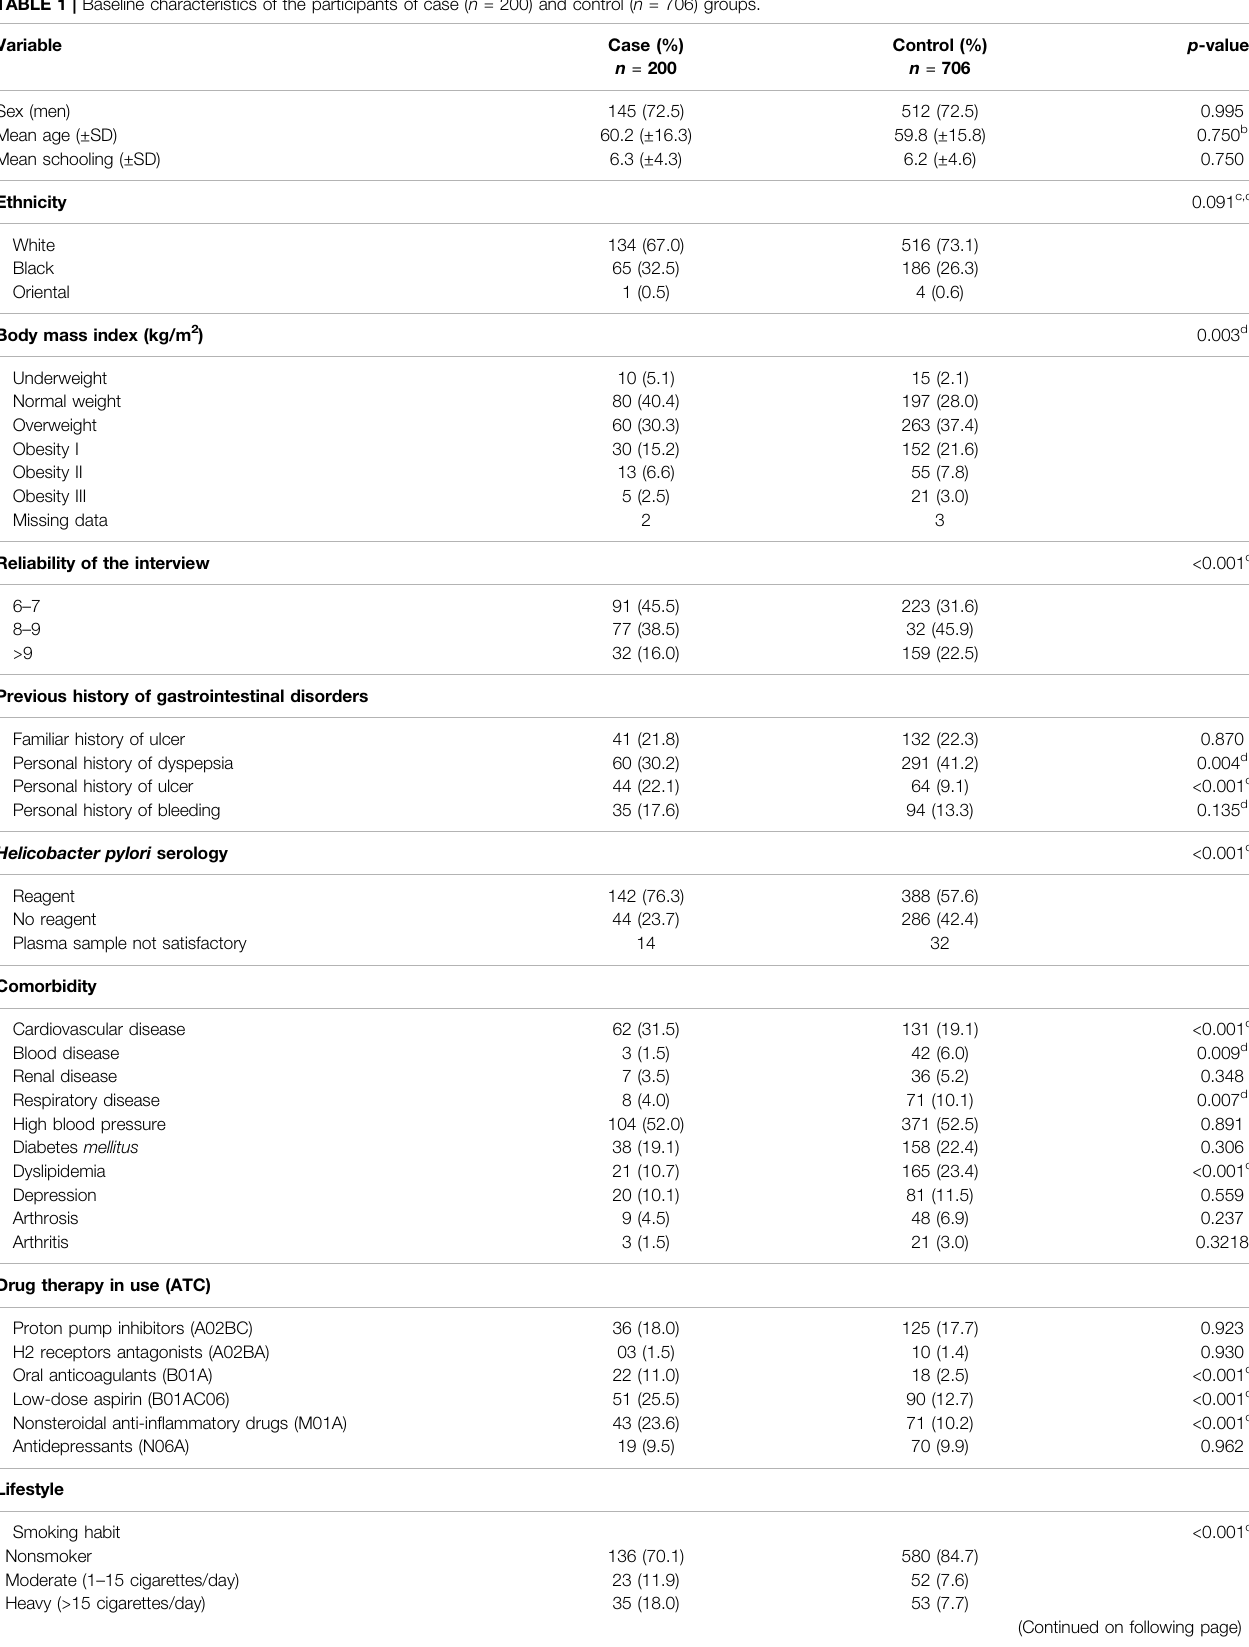
TABLE 1 | Baseline characteristics of the participants of case ( n (cid:1) 200) and control ( n (cid:1) 706)